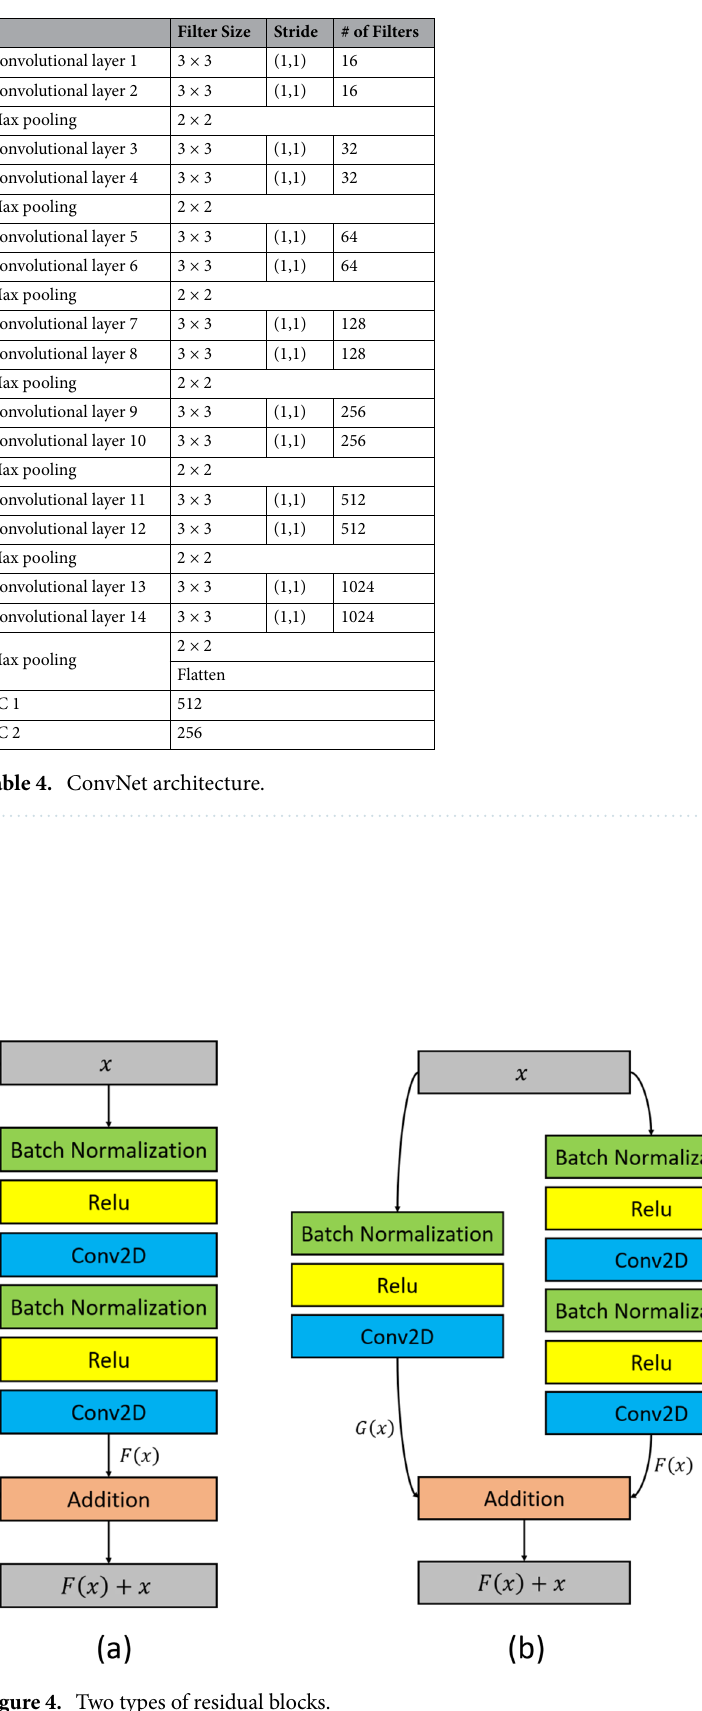
Figure 4. Two types of residual